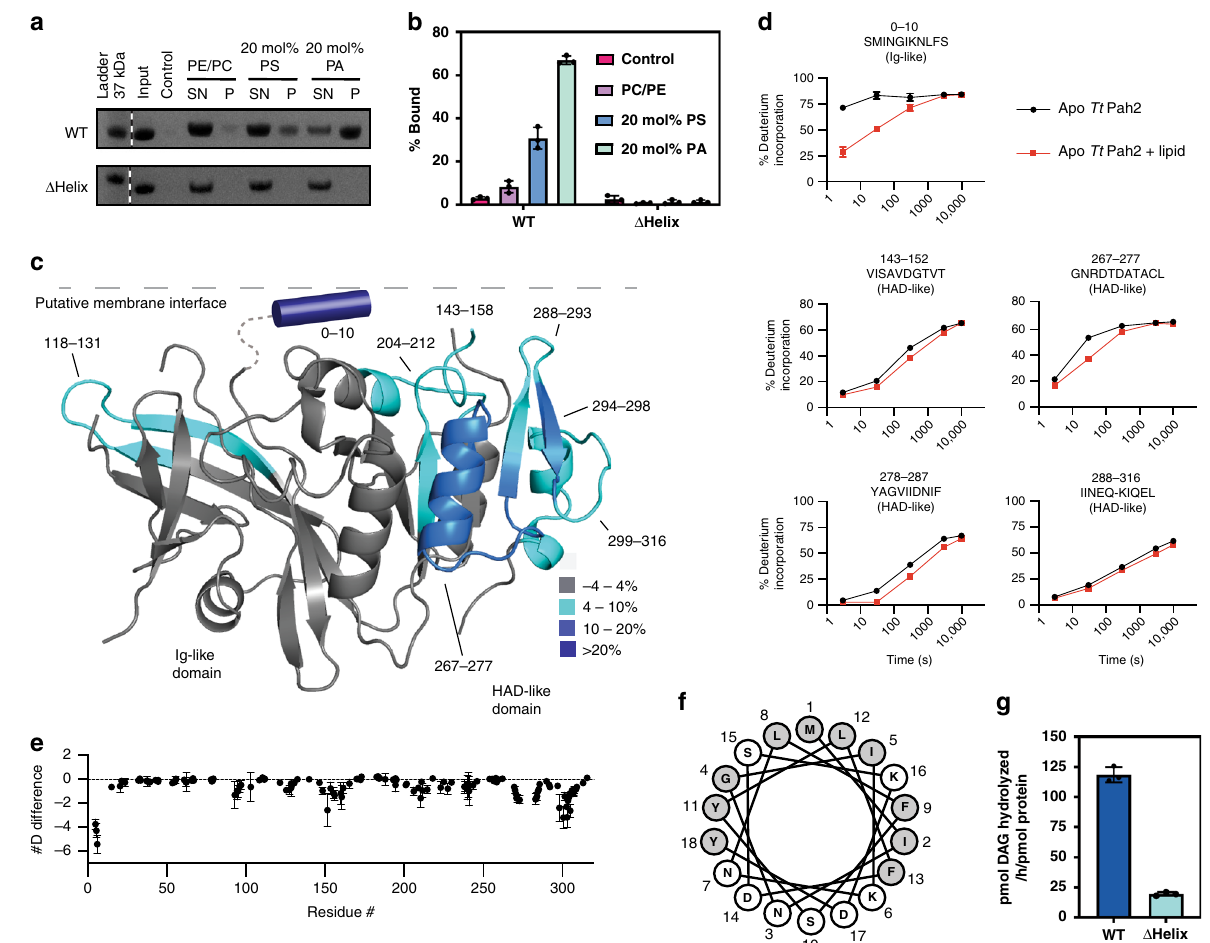
Fig. 4 HDX-MS identi fi es a putative amphipathic helix for Pah2 membrane association. a SDS-PAGE analysis of liposome sedimentation assay reveals wild-type Tt Pah2 preferentially associates with liposomes containing 20 mol% PA. Deletion of the putative amphipathic helix in Δ Helix Tt Pah2 results in loss of membrane association. SN supernatant, P pellet, PE phosphatidylethanolamine, PC phosphatidylcholine, PS phosphatidylserine, PA phosphatidic acid. b Quanti fi cation of liposome association for wild-type and Δ Helix Tt Pah2. Error bars represent standard deviation ( n = 3). c Regions of Tt Pah2 that showed signi fi cant decreases in exchange (de fi ned as >4%, >0.3 Da, and a Student ’ s t test p < 0.01) in the presence of 20% PA liposomes are colored in blue according to the legend. Peptides around the active site and a putative N-terminal amphipathic helix (blue cylinder) show the most protection from deuterium exchange. d % deuterium incorporation of selected peptides at various timepoints (3, 30, 300, 3000, and 10,000s). The strong protection of the peptide comprising residues 0 – 10 is suggestive of both a decrease of solvent exposure (due to membrane binding) and the formation of new secondary structure in the presence of membranes. The error bars represent standard deviation ( n = 3), most are smaller than the size of the point. e The sum of the # of deuterons protected from exchange in the presence of membranes across all timepoints is shown. Each point represents a single peptide, with them being graphed on the x -axis according to its central residue. Error bars represent standard deviation ( n = 3). f Helical wheel diagram of residues 1 – 18 in Tt Pah2 that were disordered in the crystal structure. Hydrophobic residues colored gray, polar residues colored white. g Deletion of the amphipathic helix in Δ Helix Tt Pah2 disrupts PAP activity. Error bars represent standard deviation ( n = 3) of experiments performed in technical duplicates. Source data are provided as a Source Data fi